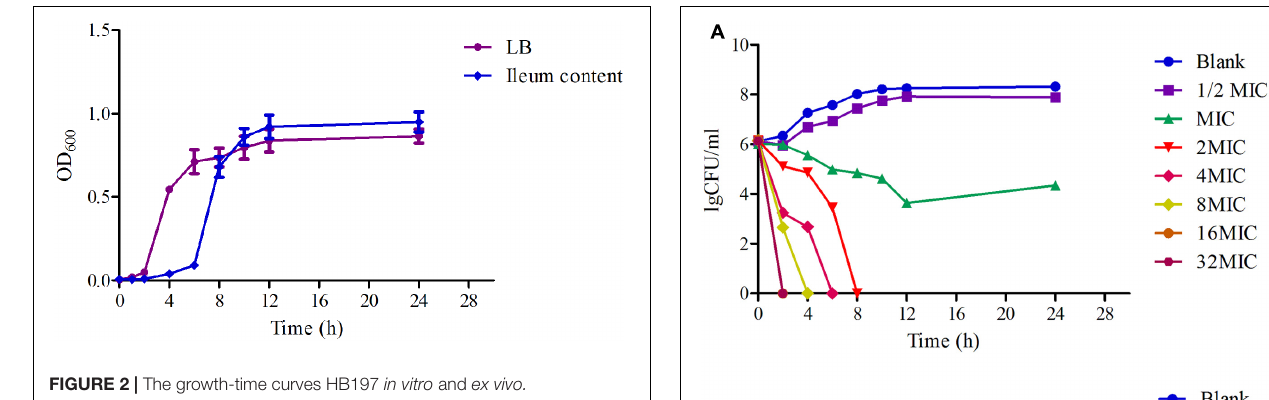
FIGURE 2 | The growth-time curves HB197 in vitro and ex vivo.